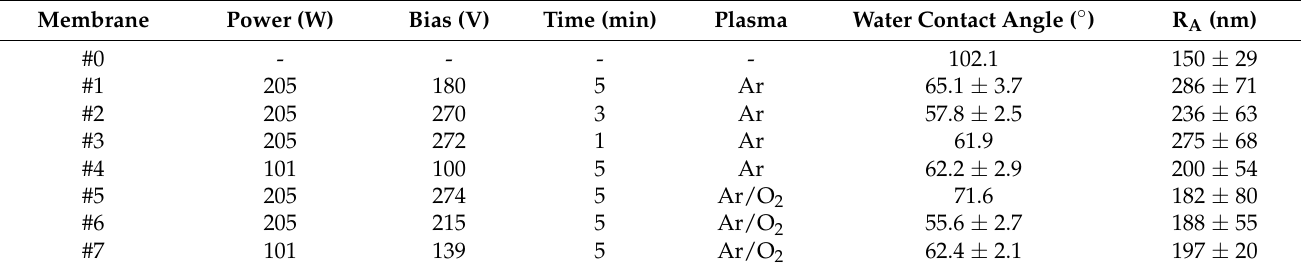
Table 2. Influence of plasma parameters on the water contact angle and membrane tortuosity.